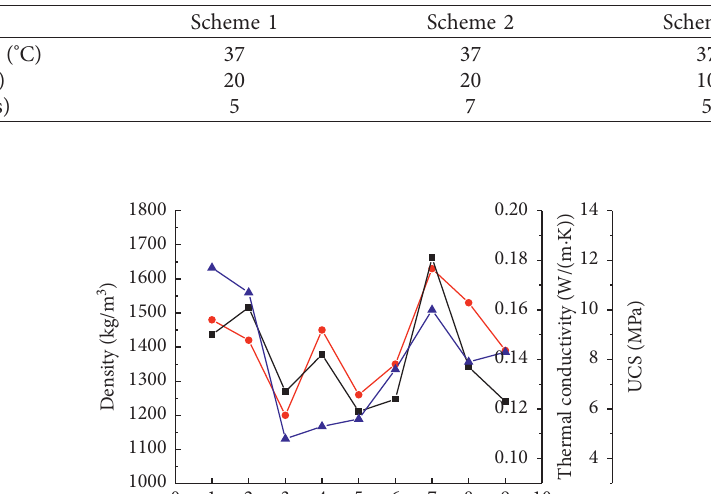
Table 3: Experimental scheme.